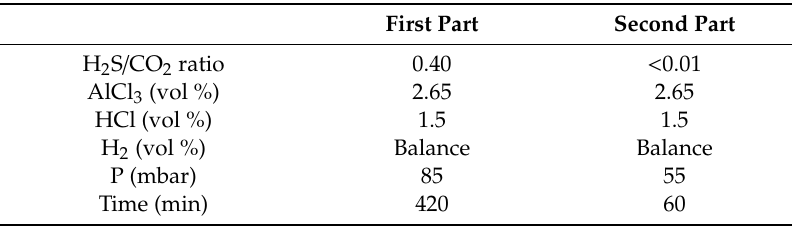
Table 4. Deposition conditions for Coating